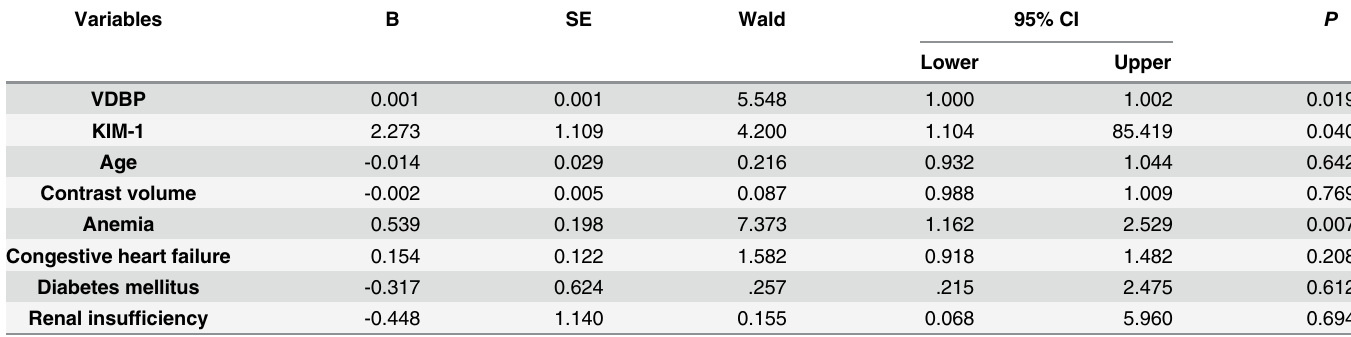
Table 5. Logistic regression analyses MARE independent variables. VDBP: vitamin D binding protein, KIM-1: kidney injury molecule 1, p < 0.05 – is statis- tically significant.